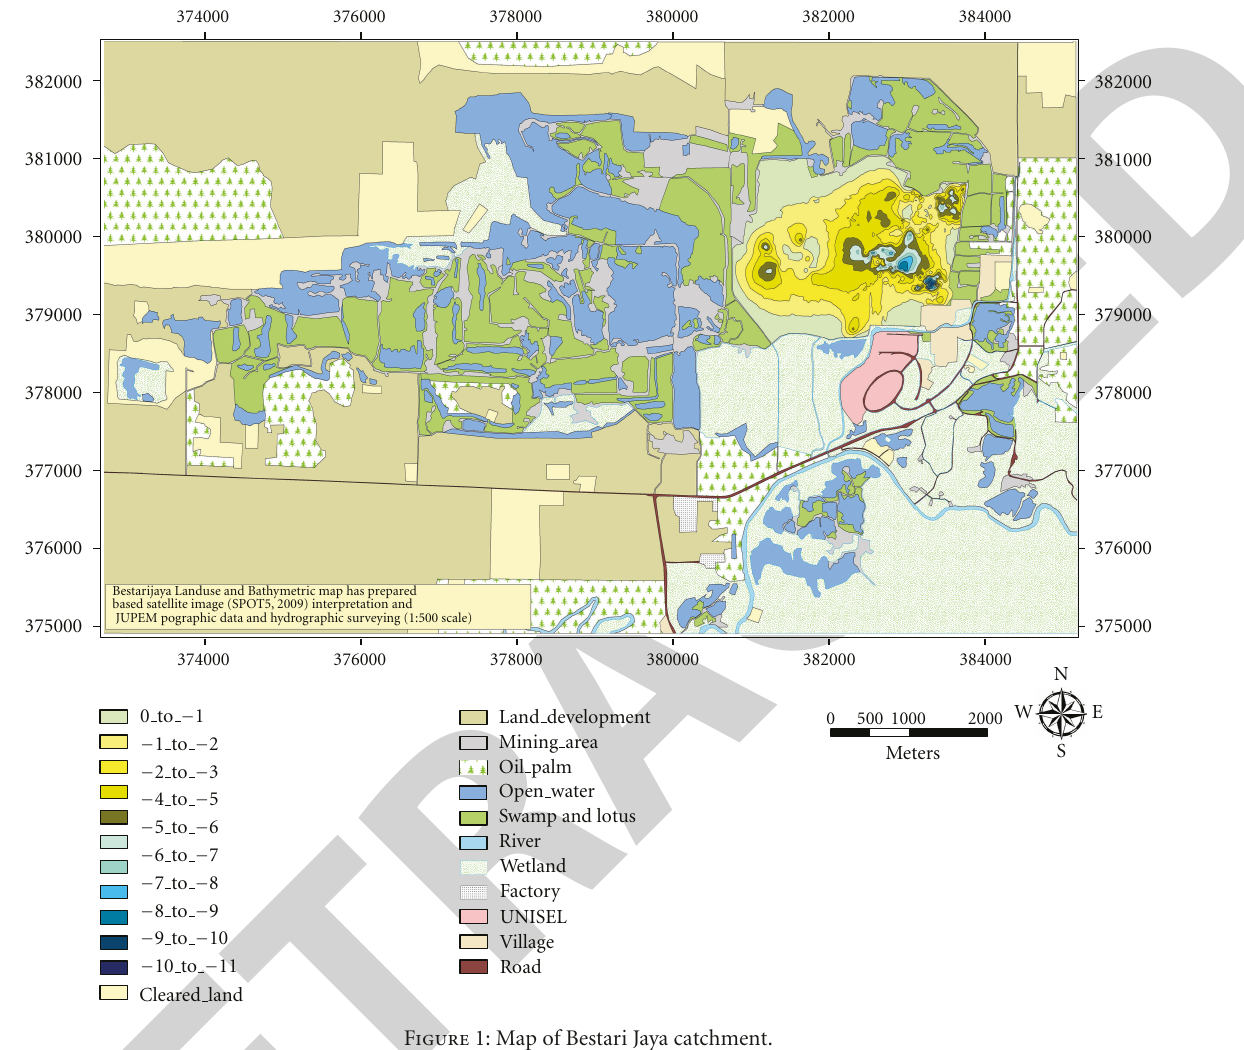
Figure 1: Map of Bestari Jaya